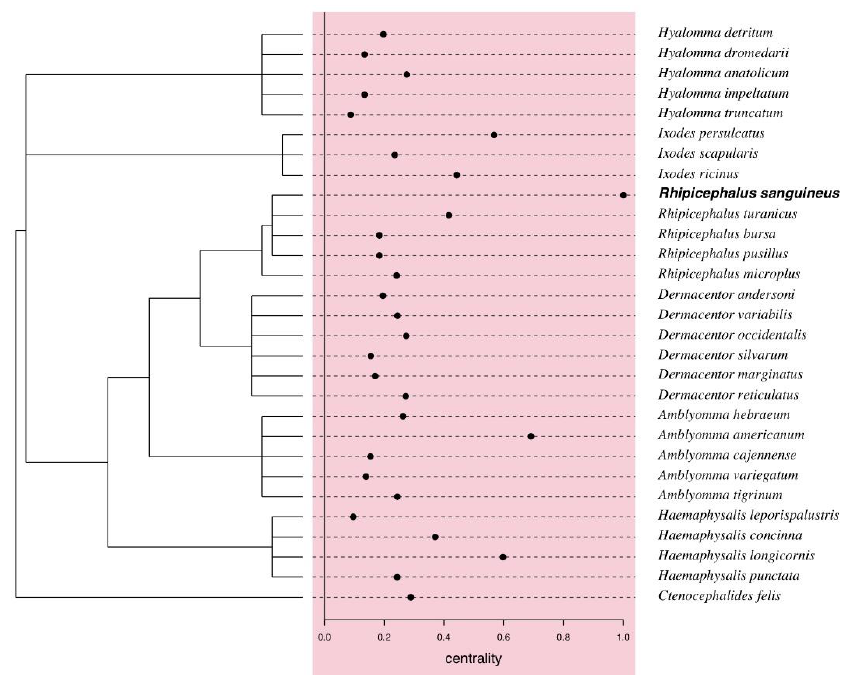
Figure 6. Centrality values of arthropod carriers of rickettsial species extracted from unipartite network (Figure 4A), with phylogenetic tree of arthropods obtained using ‘rotl’ [30] retrieved from the Tree of Life [31]. No significant phylogenetic signal for the centrality values was detected.